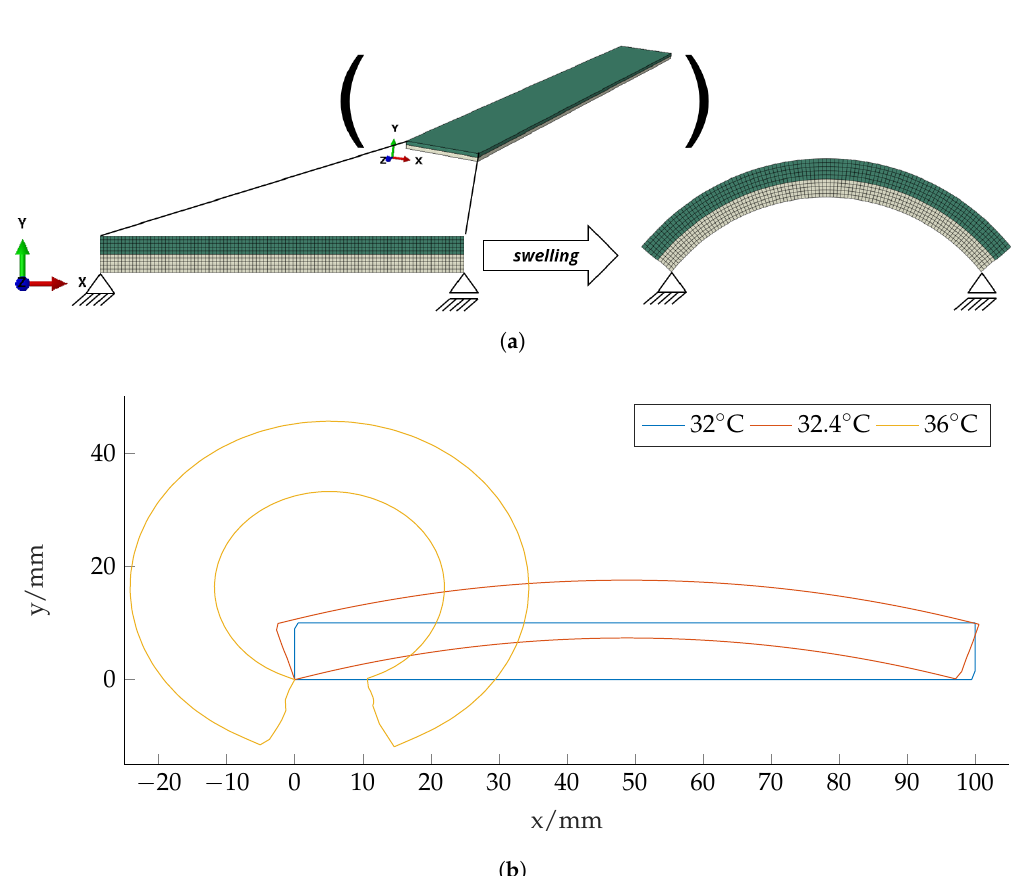
Figure 6. Basic concept and 2D simulation results for the cross-section of the U-forming beam made of two layers. ( a ) Two-dimensional swelling of an active–passive composite structure. The structure represents the cross-section of a beam according to Figure 1b, the beam-length direction is out of plane ( z -direction). In this Finite-Element simulation result, we observe the wanted effect from Figure 1a: under swelling, the cross-section forms an inverted U which leads to an increased bending stiffness. ( b ) Beam cross-section at different temperature states and according two-layer structure.